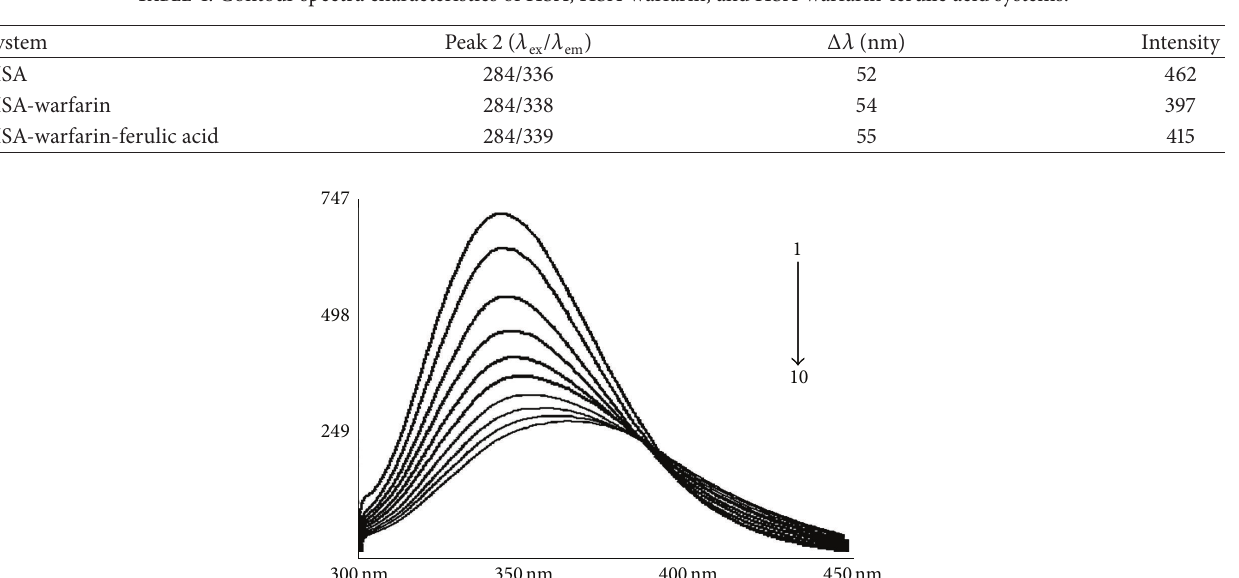
Figure8:Fluorescencespectraoftheeffectofferulicacidonwarfarin-HSA,formcurve 1 → 10 , 𝐶 ( = 0, 2, 4,6, 8, 10, 12, 14, 16 × 10 −6 M, respectively. and 𝐶 ( warfarin )